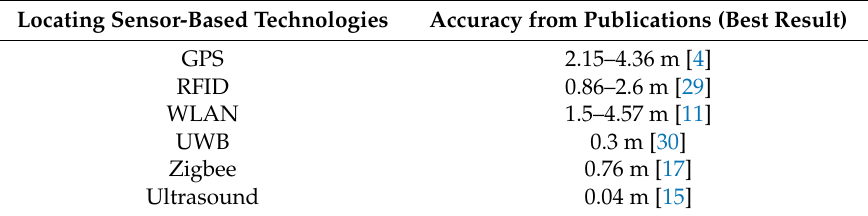
Table 1. Accuracy of locating sensor-based